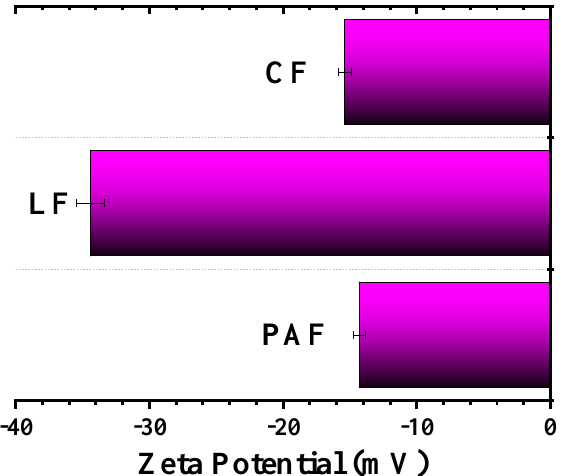
Figure 4. Zeta-potential for pristine linen fiber (LF) and its chemically treated forms (CF and PAF) acquired at pH ~7.